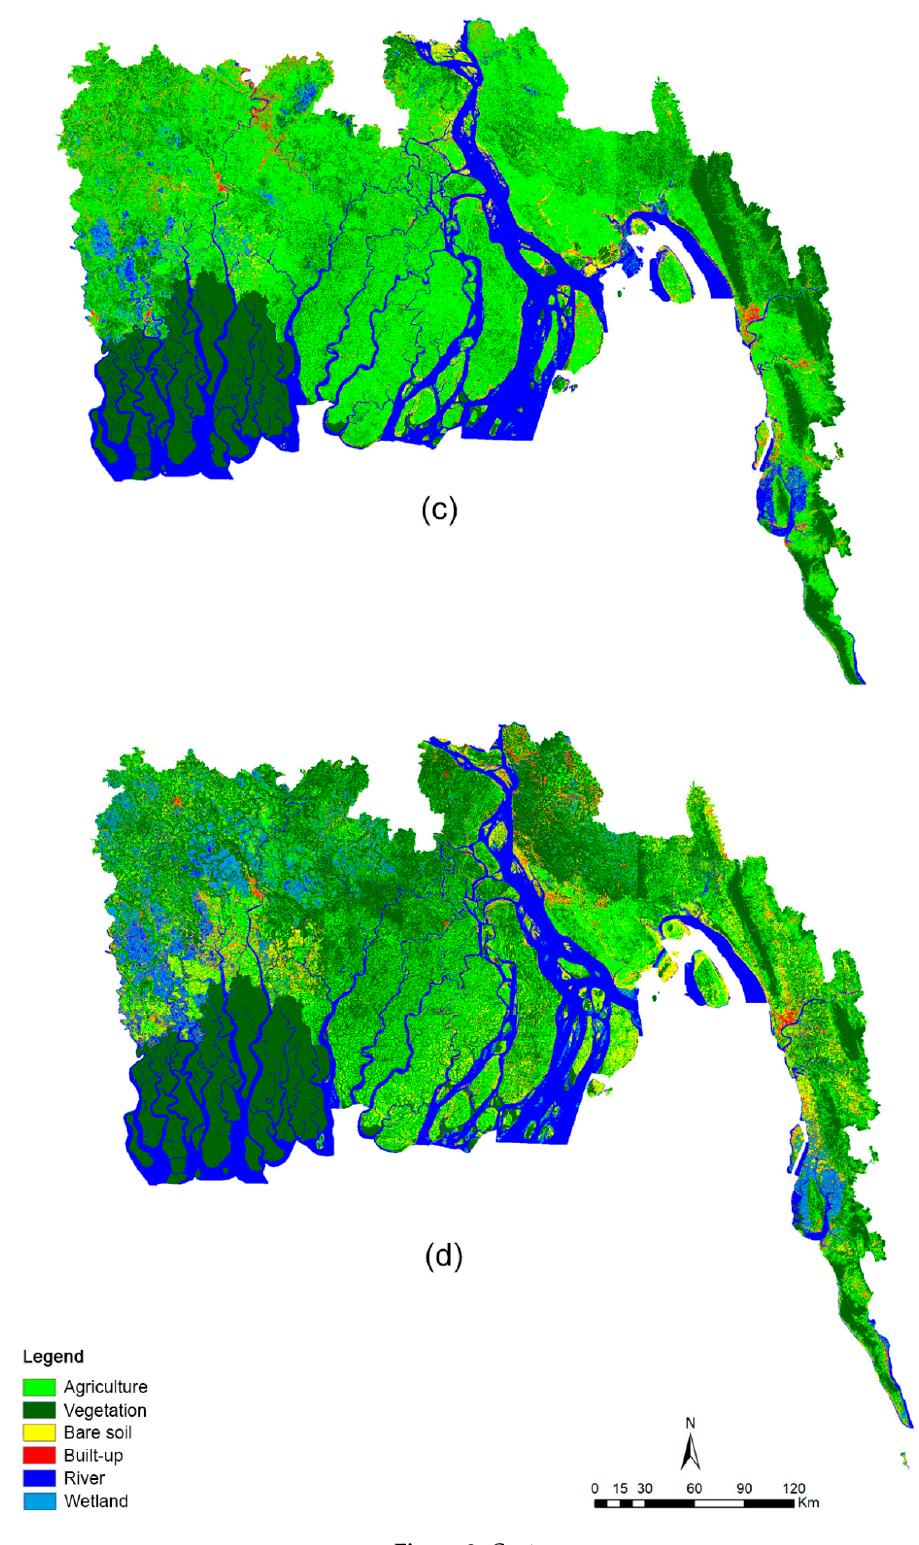
Figure 3. Figure 3 contin. Classified land cover maps of the coastal area of Bangladesh: (c) 2000 and (d) 2005.